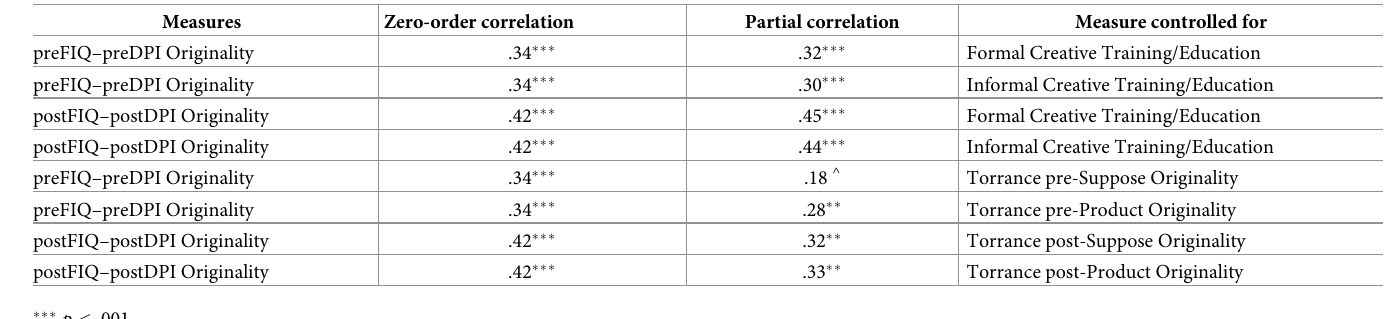
Table 9. Partial correlation analyses for FIQ originality with Design Product